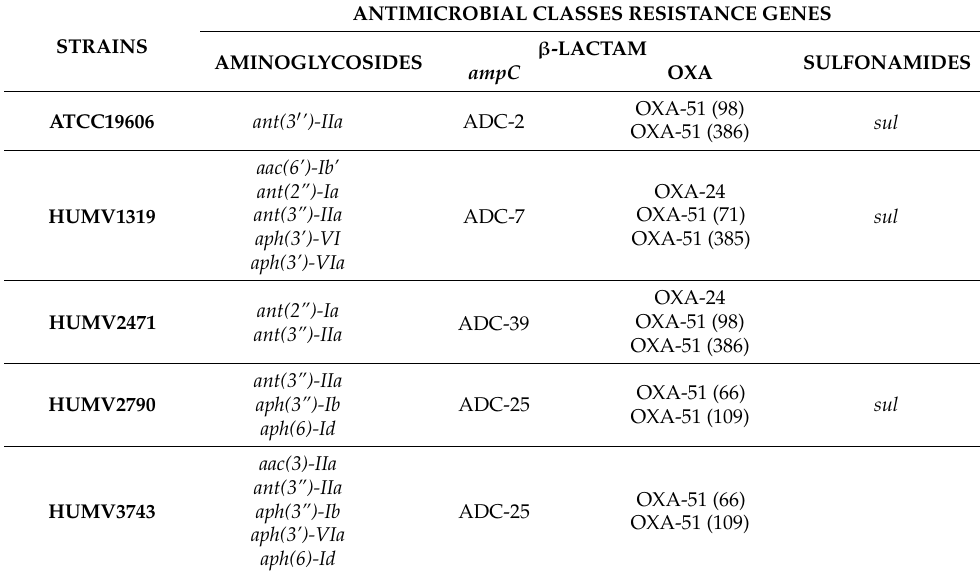
Table 3. Antimicrobial resistance genes identified with Prokka and CARD databases.